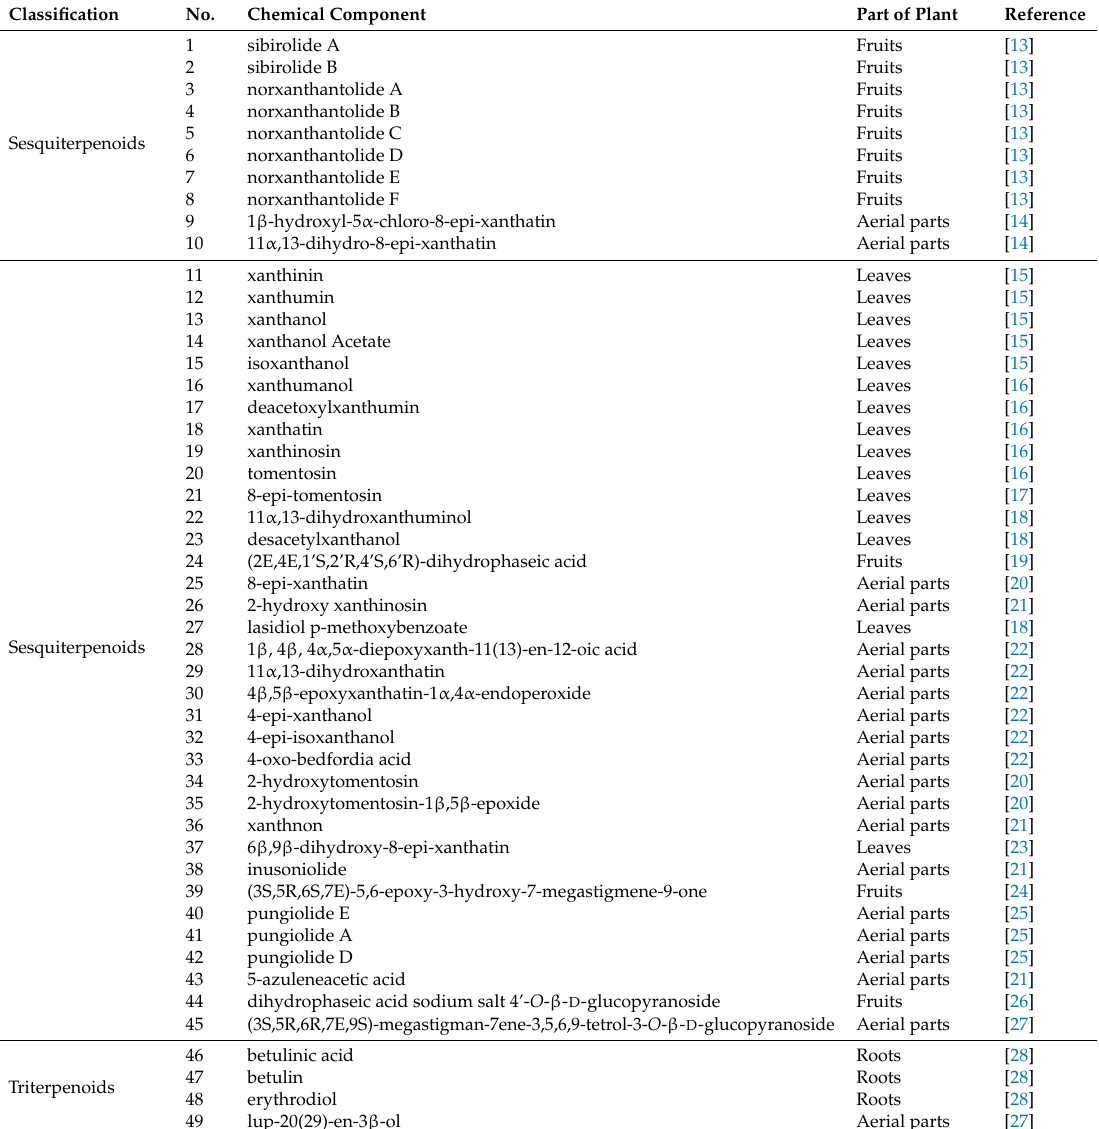
Table 2. Chemical constituents isolated from X. strumarium